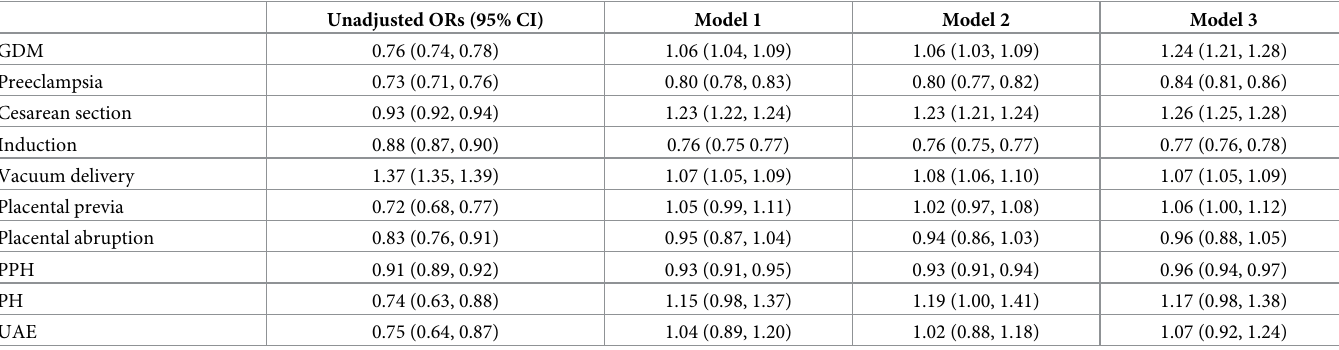
Discussion In this study, we evaluated pregnancy outcomes according to maternal ethnicity and found dif- ferences in pregnancy outcomes. Immigrant women were protected against having preeclamp- sia and PPH and higher risk of GDM, and CS compared to Korean women after adjustment for age, parity, and CCI. Table 3. Odds ratio and 95% confidence intervals of adverse pregnancy outcomes of 155 immigrant